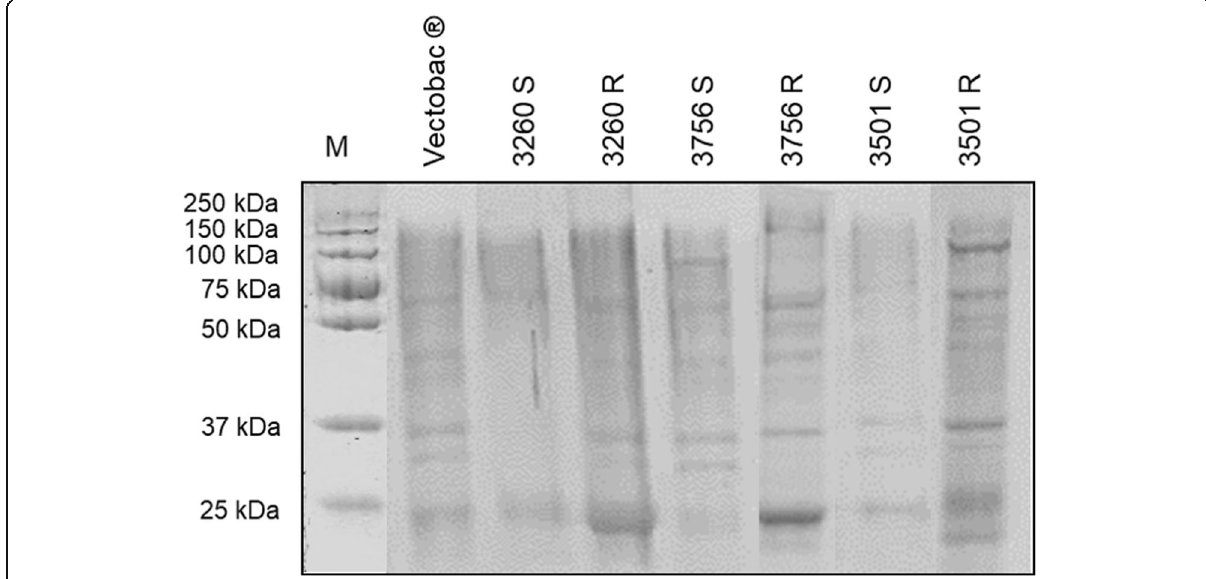
Fig. 3 SDS-PAGE protein analysis of stored (S) and reactivated (R) HD extracts of Bacillus thuringiensis var. israelensis ( Bti ), Protein Marker (M) PageRuler® Stained with Coomassie® Brilliant blue G